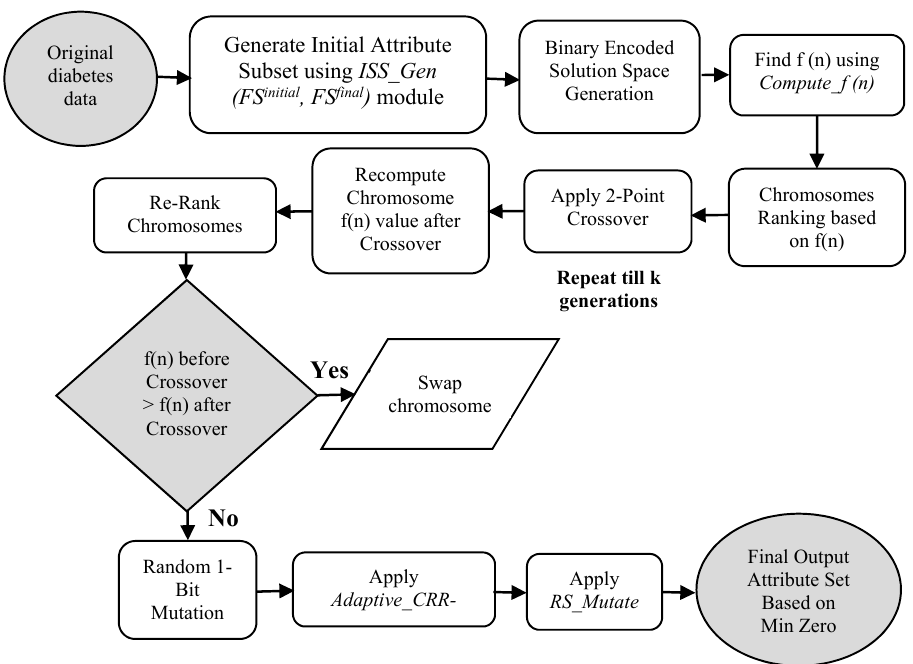
Figure 2. Proposed Optimized Attribute Selection Method.